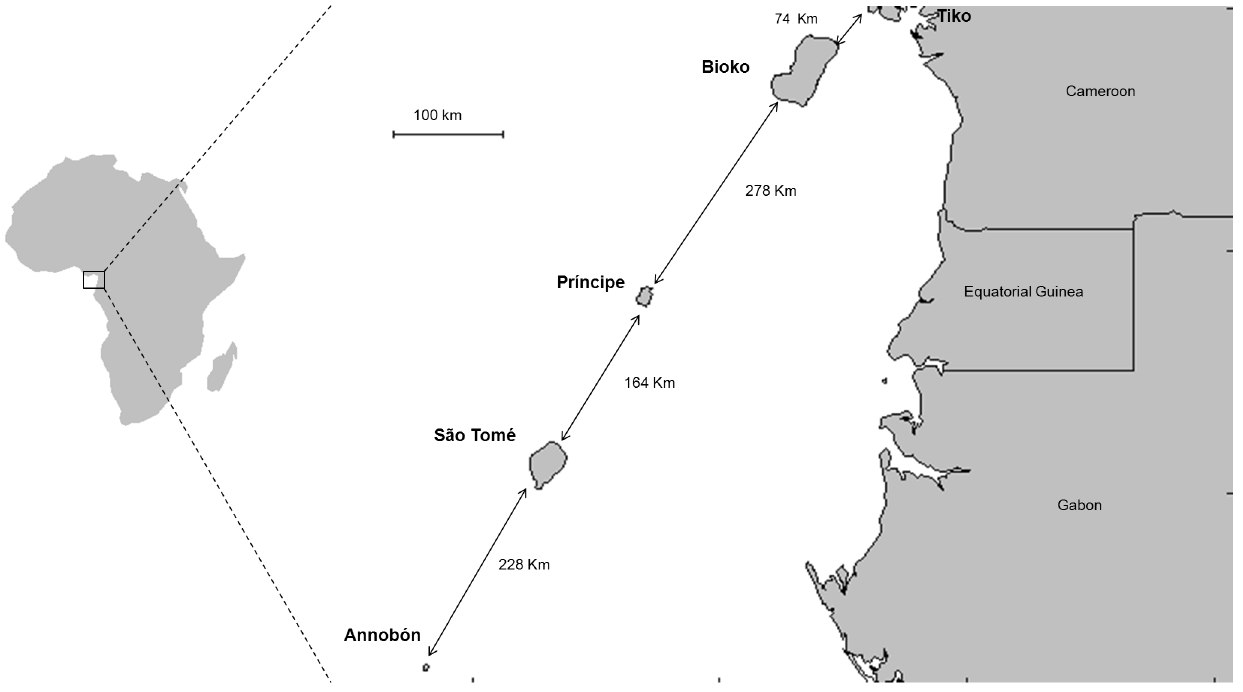
Figure 1. Map of the Gulf of Guinea displaying the islands where collections were conducted and the geographic linear distances among them.